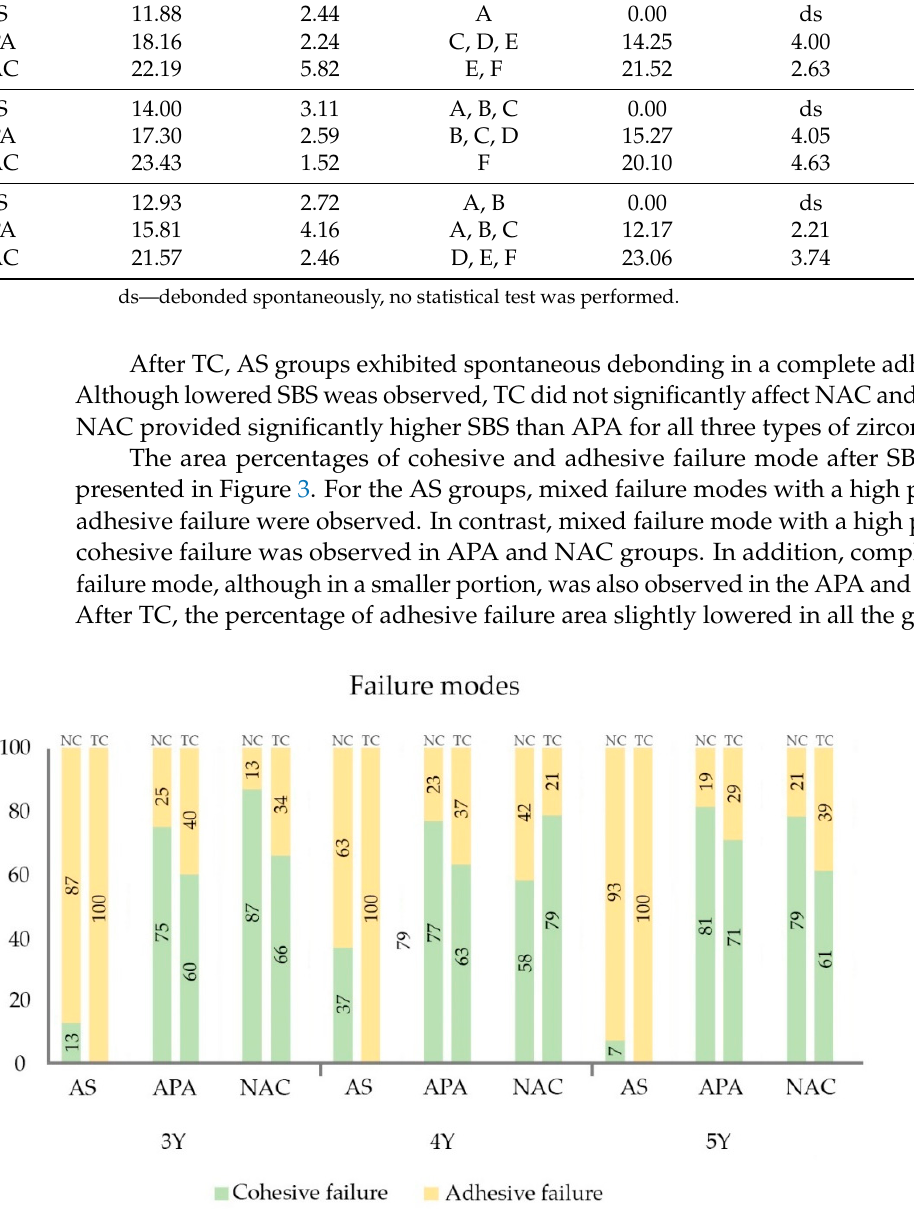
( a ) ( b ) ( c ) Figure 4. Light microscopy micrographs (insets) and SEM micrographs of different failure modes of representative speci- mens: ( a ) adhesive failure mode of AS specimen—at magnification ×3.5 complete adhesive failure is evident and at mag- nification ×10,000 exposed zirconia grains (white arrow) and residing cement fillers (black arrow) are observed; ( b ) mixed failure mode of APA specimen - at magnification ×3.5 a low percentage of adhesive failure is evident and, at magnification ×1000, cement remnants (black arrow), surface flaws, and sharp indentations (white arrows) caused by APA are observed; ( c ) mixed failure mode with a predominantly cohesive fracture of an NAC specimen, at magnification ×3.5 thick cement residue (white arrow), is observed with a small adhesive failure and, at magnification ×10,000, exposed zirconia grains covered with NAC residue (white arrows) are observed. 3.2. Translucency SEM micrographs of polished and thermally etched 3Y, 4Y, and 5Y zirconia are shown in Figure 5a–f. The microstructure of the zirconia ceramics revealed polycrystalline and dense structures with only occasionally very few pores. The three zirconia ceramics differed in microstructure for grain size. The size of the zirconia grains increased with the amount of yttria; the largest grains were observed in the 5Y group. The d50 diameters of 3Y, 4Y, and 5Y were 0.28, 0.32, and 0.53 µm, respectively.